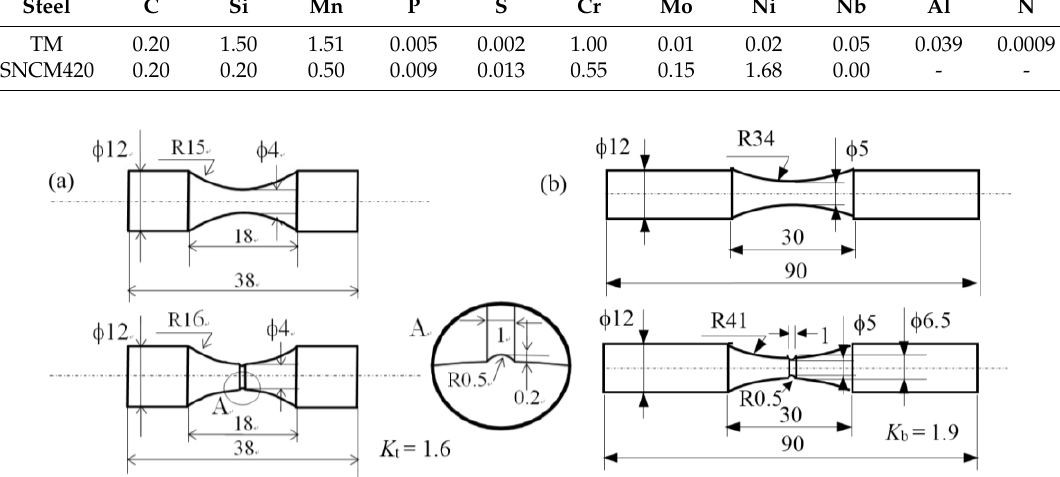
Figure 1. Dimensions of smooth and notched specimens for ( a ) torsional and ( b ) rotational bending fatigue tests. K t and K b are stress concentration factors for torsion and bending. All dimensions are in mm.